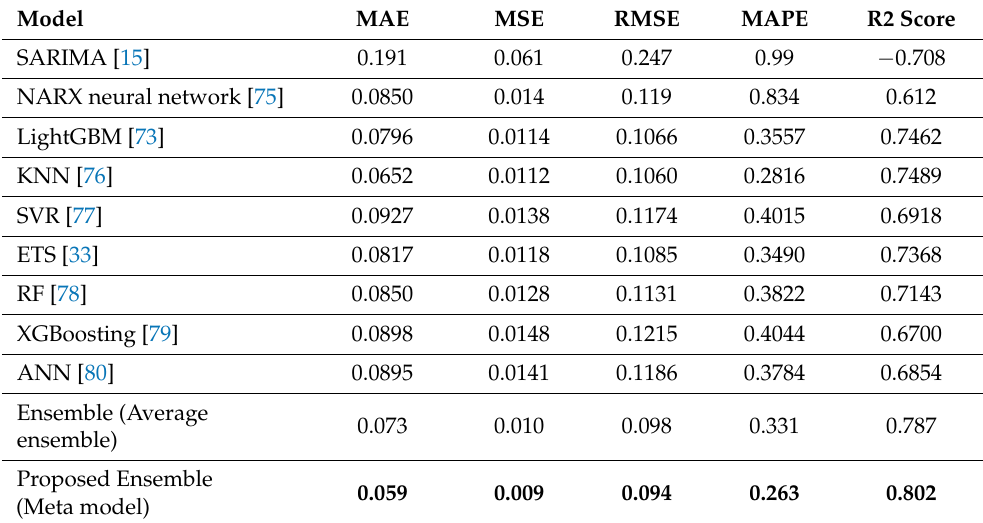
Performance comparison between the proposed ensemble method and existing ML